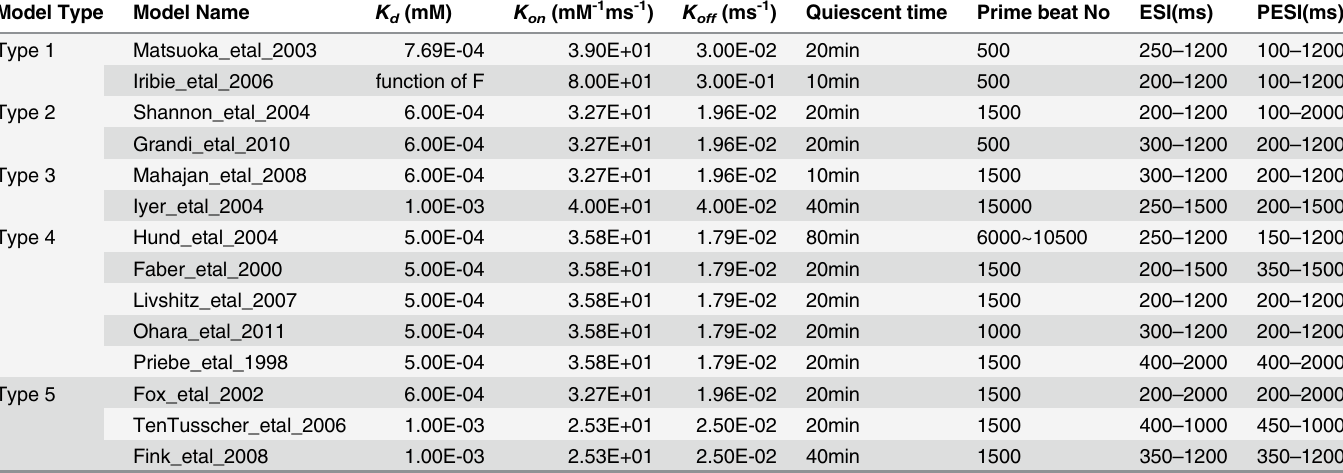
Table 3. General information of 14 electrophysiological models including parameters of CaTRPN ( K d , K on , K off ), approximate time to reach quies- cent states, beat number to reach priming steady states and ESI,PESI ranges. Model